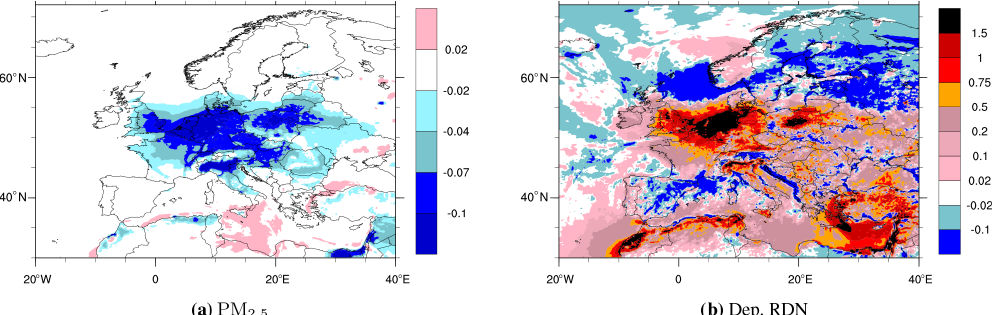
Figure 8. Difference between additional 50%–40% reduction and additional Base–10% in NH 3 emissions on top of NEC 2030 for PM 2 . 5 concentrations (µgm − 3 ) (a) and deposition of reduced nitrogen (mgNm − 2 ) (b)